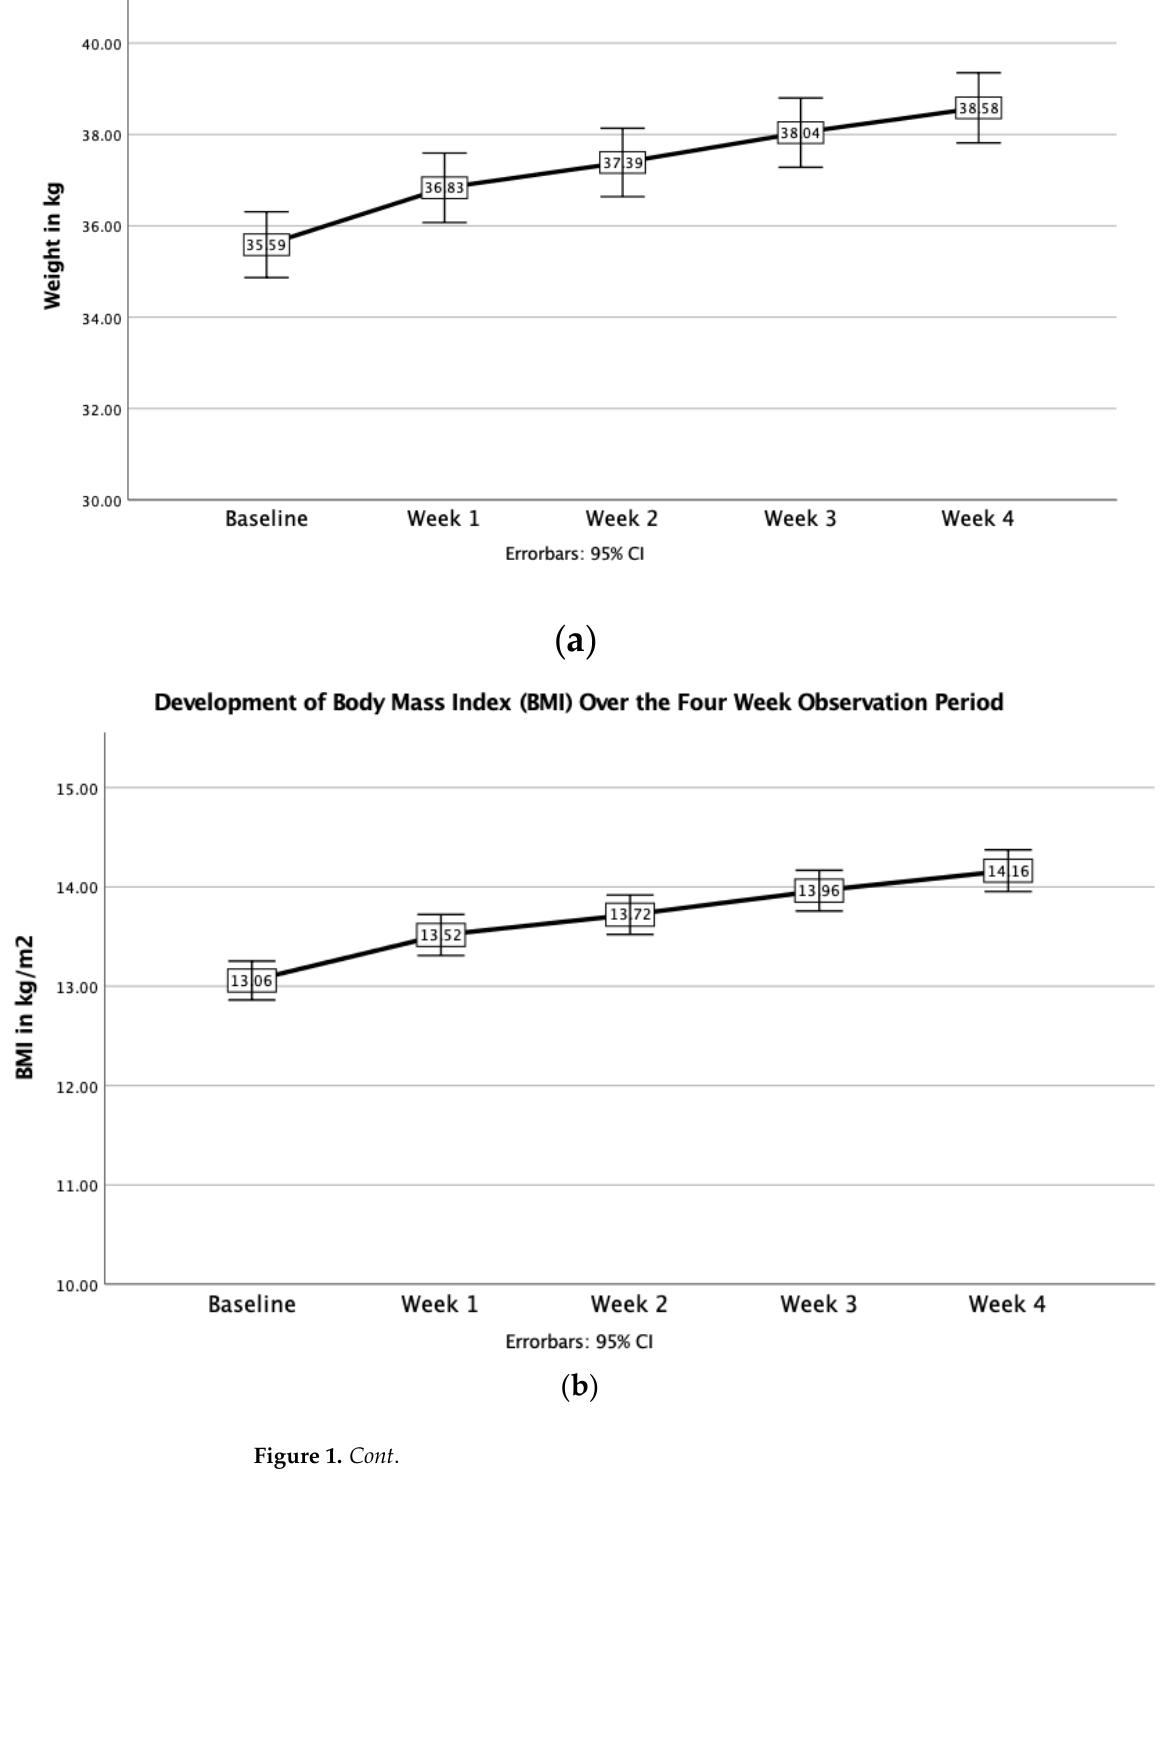
( c ) Figure 1. ( a ) Development of body weight over 28 days. ( b ) Development of BMI over 28 days. ( c ) Development of serum phosphate over 28 days . In week 1, 14 patients (11.7%) experienced weight gain between 0.1 and 0.5 kg, 18 patients (15.0%) gained between 0.51 and 1.0 kg, 43 patients (35.8%) gained between 1.01 and 2.0 kg, 21 patients (17.5%) gained between 2.01 and 4.0 kg and 4 patients (3.3%) gained more than 4.0 kg. The highest weight gain in week 1 was 5.7 kg. The consistent fall